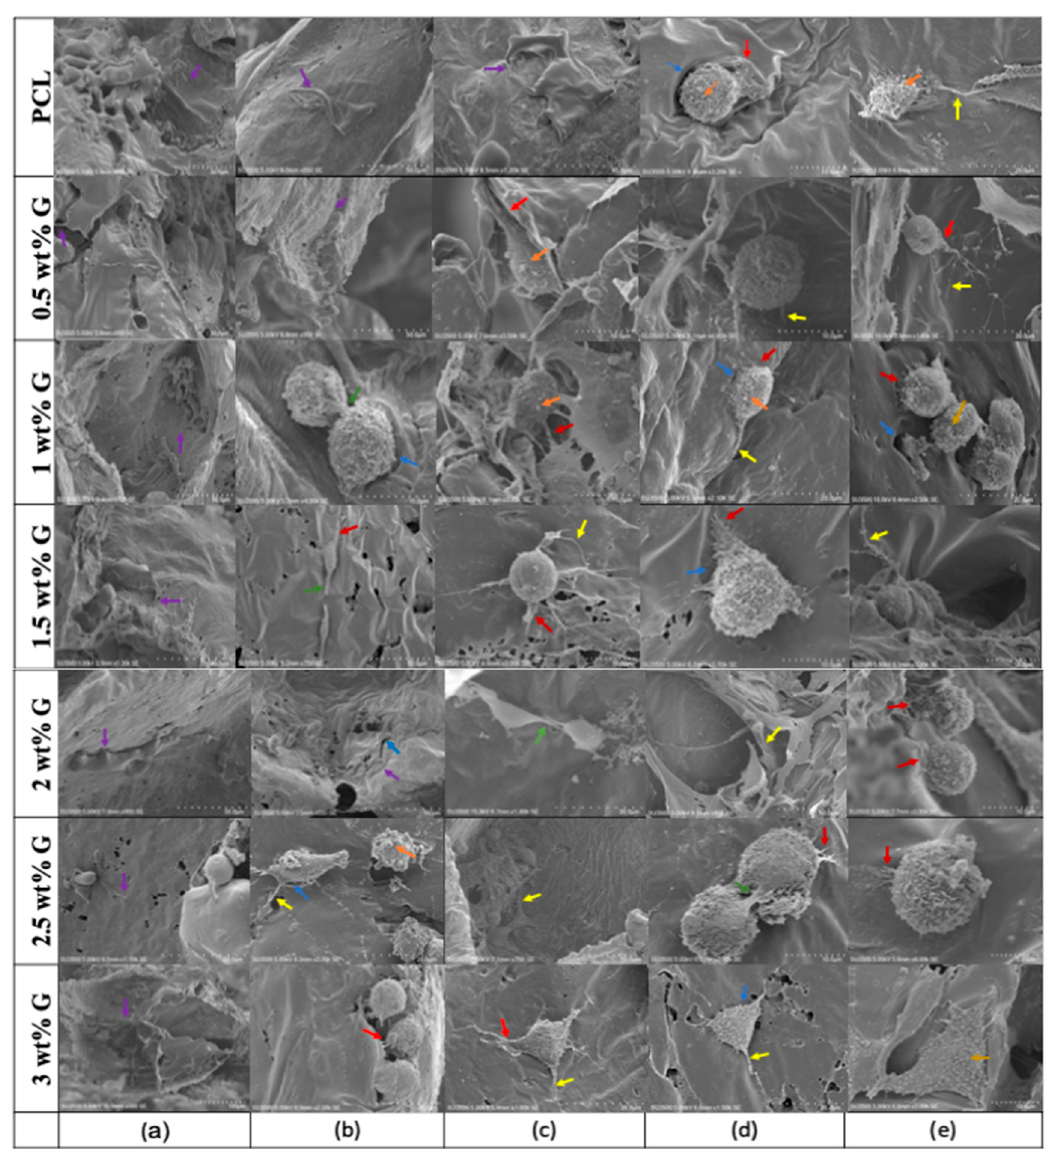
Figure 7. SEM showing the morphology of osteoblast-like (MG-63) cells on days ( a ) 1, ( b ) 4, ( c ) 7, ( d ) 14, and ( e ) 21. Protrusion of cellular body and pores on the surface of scaffold: = lamellipodia; = intercellular connections; = filopodia and micro-vesicles.